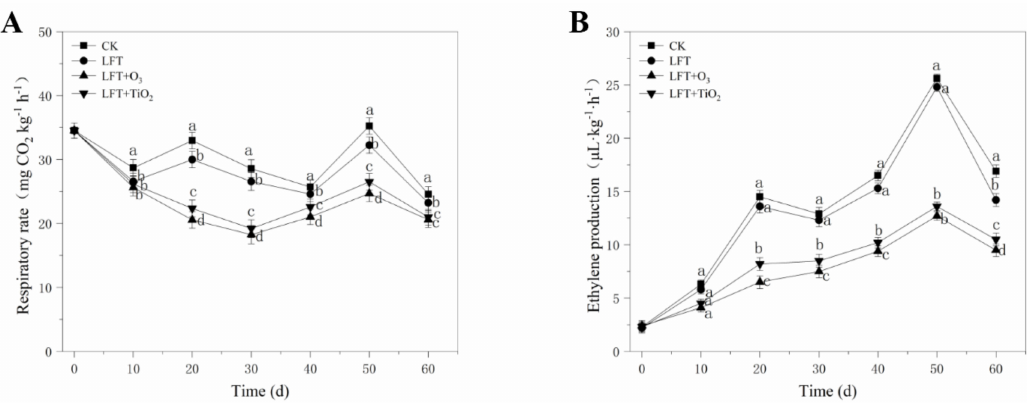
Figure 4. E ff ect of control (CK), LFT, LFT combined with ozone treatment (LFT + O 3 ) and LFT combined with TiO 2 photocatalytic (LFT + TiO 2 ) treatments on the respiratory rate and ethylene production of peaches during storage at 0 ◦ C for 60 d. Values are expressed as means ± SD ( n = 10). Di ff erent letters (a–d) indicate significant di ff erences among treatments for each sampling time at p < 0.05. ( A ) Respiratory rate. ( B ) Ethylene